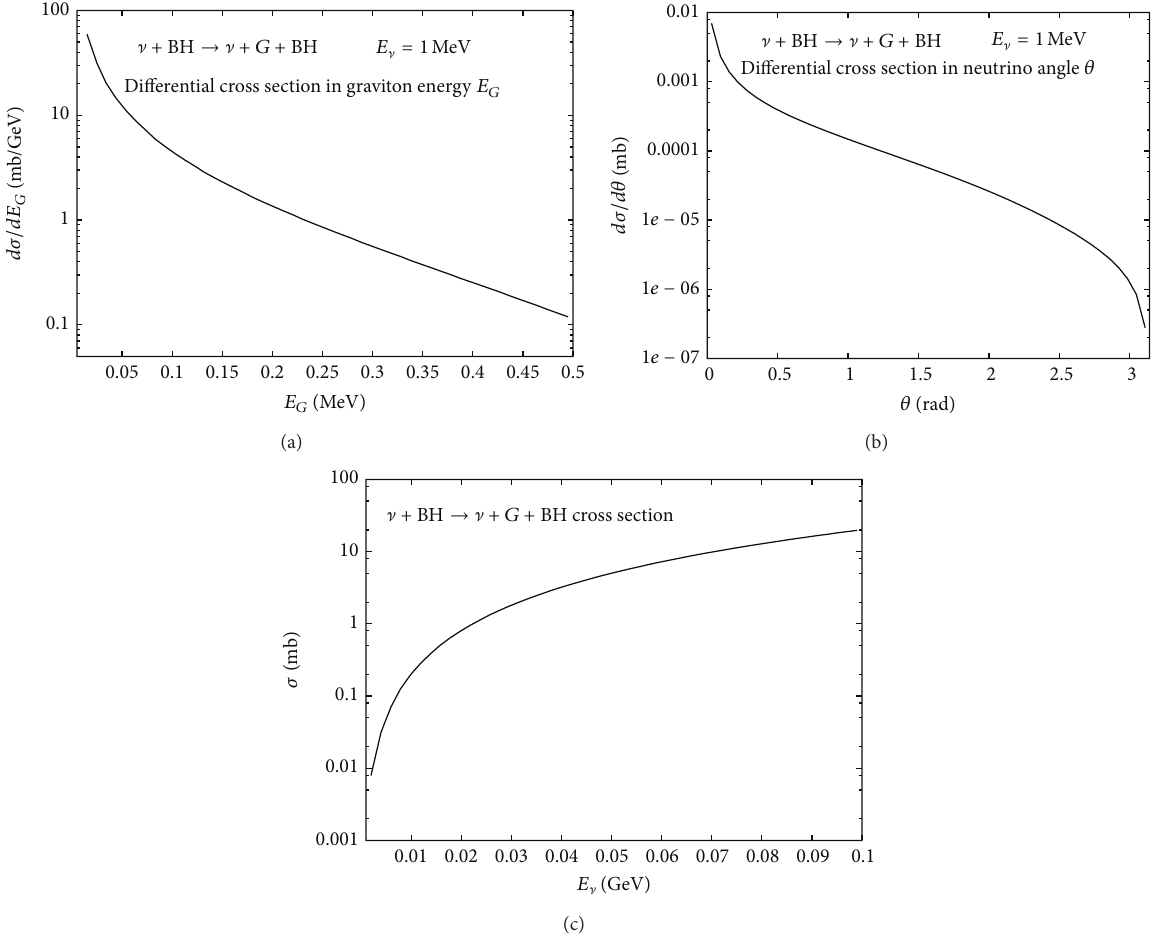
Figure 3: Differential cross section of the gravitational Bethe-Heitler scattering of neutrino off a massive object, for example, a black hole (BH) in radiated graviton energy 𝐸 𝐺 (a), in polar angle of the final-state neutrino 𝜃 ] (b), and the integrated cross section as a function of incoming neutrino energy 𝐸 ] typical for astrophysical sources, for example, see [69],